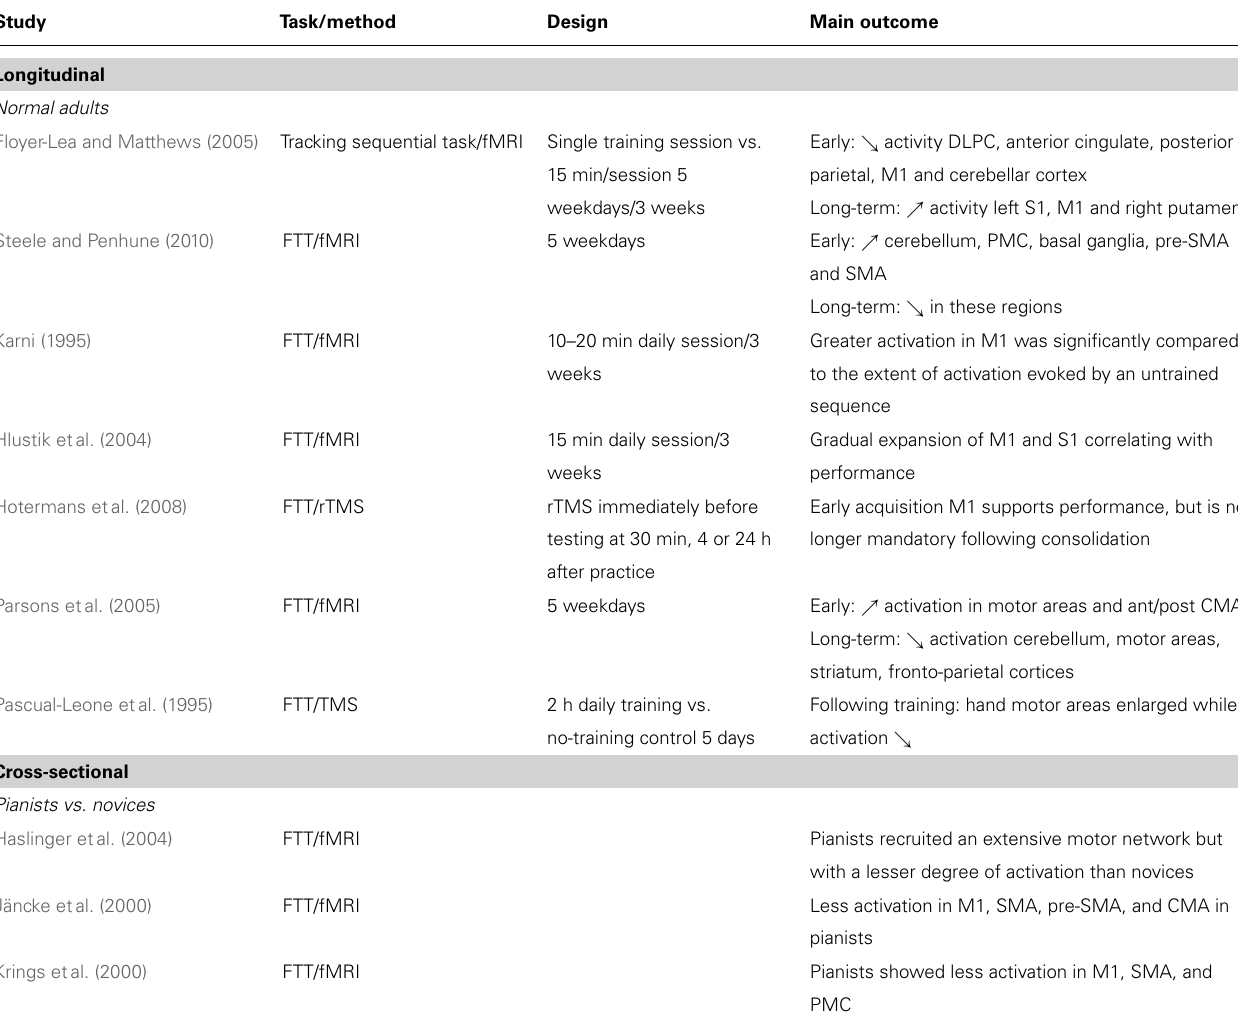
Table 1 | Functional plasticity through longitudinal and cross-sectional approaches: focus on the motor network. Study Task/method Design Main outcome Longitudinal Normal adults Floyer-Lea and Matthews (2005) Tracking sequential task/fMRI Single training session